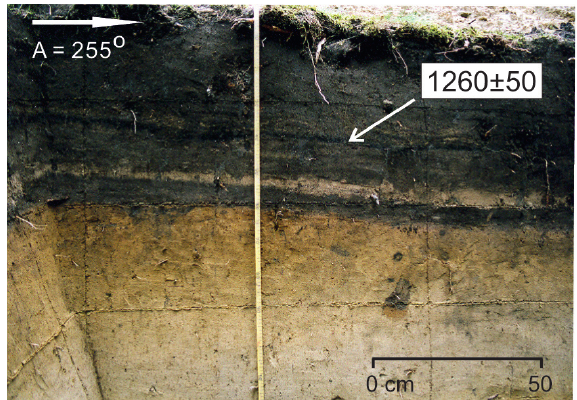
Fig. 2. Dated slash­and­burn level and series of slope sediments in the Z­1